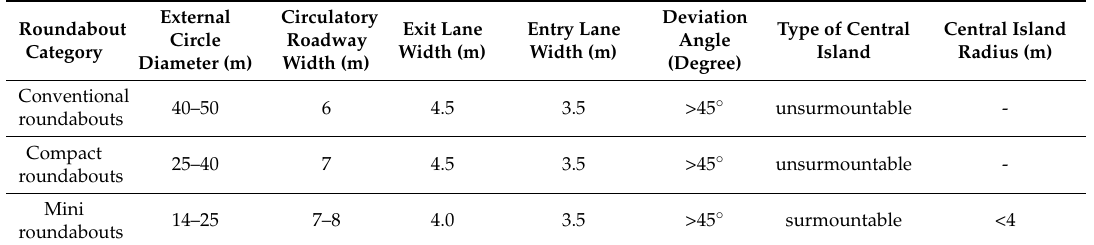
Table 1. Characteristics of roundabouts according to the Italian